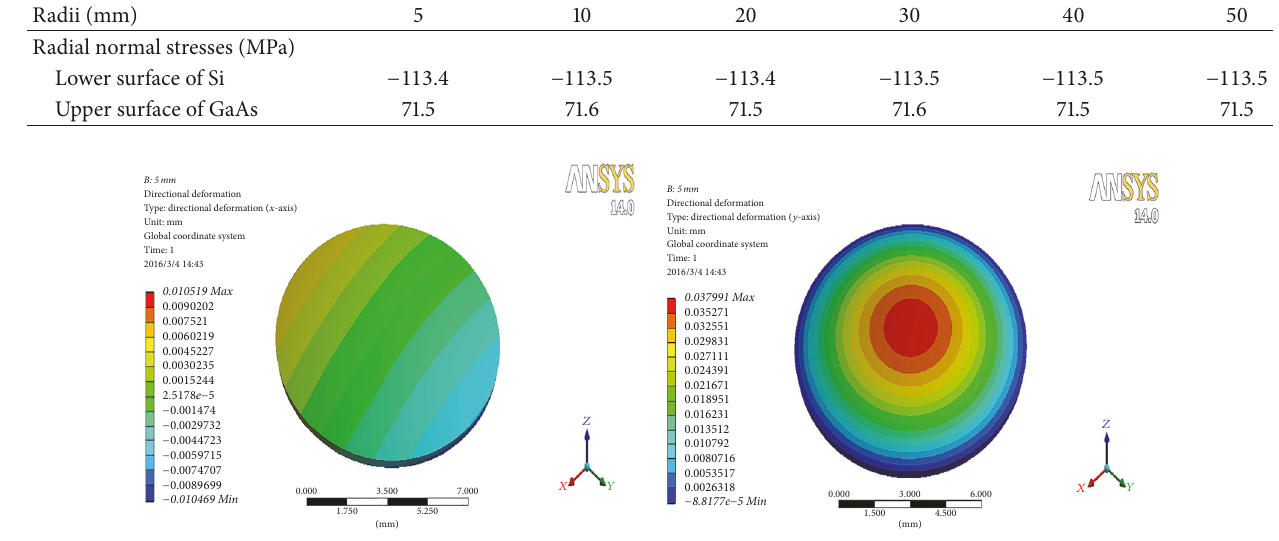
Table 1: Radial normal stresses away from the edge region of the bonding interfaces with different radii. Radii (mm)